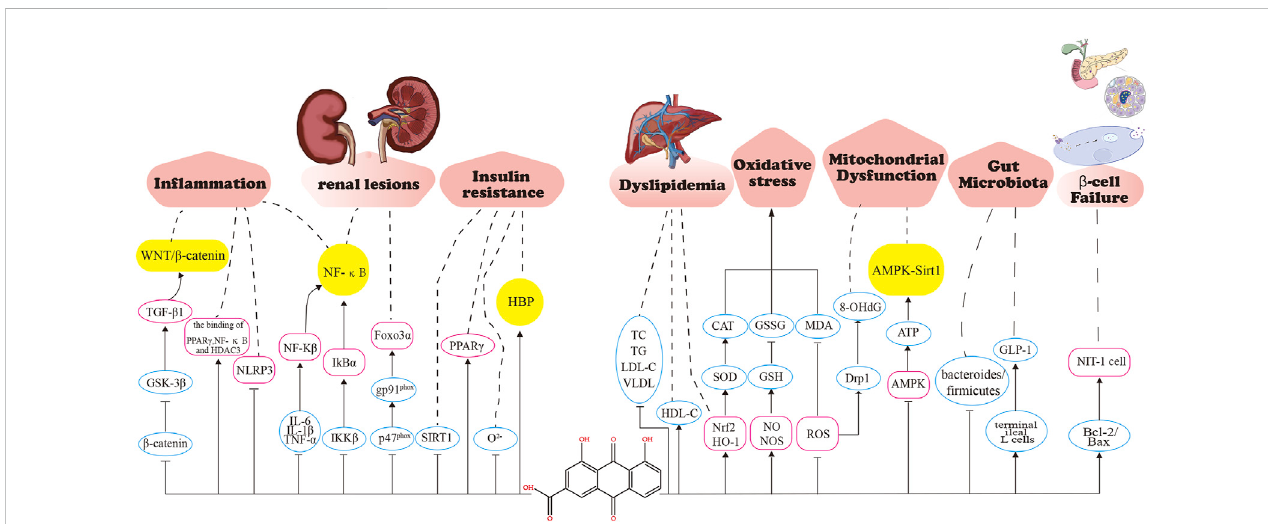
FIGURE 5 Pharmacological mechanisms of rhein in diabetes mellitus. Rhein maintains glucose homeostasis by anti-in fl ammation, alleviating renal lesions, improving insulin resistance, improving lipid metabolism, anti-oxidative stress, maintainingmitochondrial respiratory function, improvinggut microbiota, and improving β -cell functional. GSK-3 β , Glycogen synthase kinase 3 β ; PPAR- γ ,peroxisome proliferator-activated receptor γ ; NF- κ B, nuclear factor kappa-B; HDAC3, histonedeacetylase 3;NLRP3,NOD-likereceptorthermalproteindomain associated protein3;IL-6, Interleukin-6; IL-1 β ,Interleukin-1 β ;TNF- α ,tumor necrosis factor α ; IKK β ,inhibitor of kappa B kinase β ;Foxo3 α , Forkhead box 03 α ; SIRT1, sirtuin 1; HBP, Hexosamine pathway; TC, Serum total cholesterol; HDL-C,High density liptein cholesterol; TG, triacylglycerol; LDL-C, Low-Density Lipoprotein Cholesterol; VLDL,very low-density lipoprotein; SOD, Superoxide dismutase; CAT,Catalase from micrococcus lysodeiktic; GSH,glutathione,reduced; GSSG, glutathione, oxydized; MDA, malonaldehyde; ROS, reactive oxygen species; Drpl,Dynamin-related protein 1; AMPK,Adenosine 5 ’ -monophosphate (AMP)-activated protein kinase; GLP-1,glucagon-like peptide-1; Bcl-2,B-cell lymphoma-2; BAX,BCL2-Associated